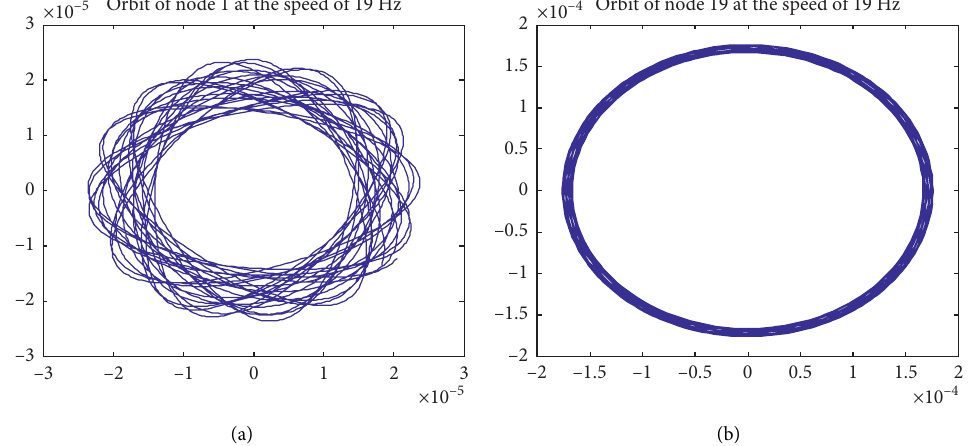
Figure 18: Orbits of bearings without misalignment ( Δ � 0mm, Ω